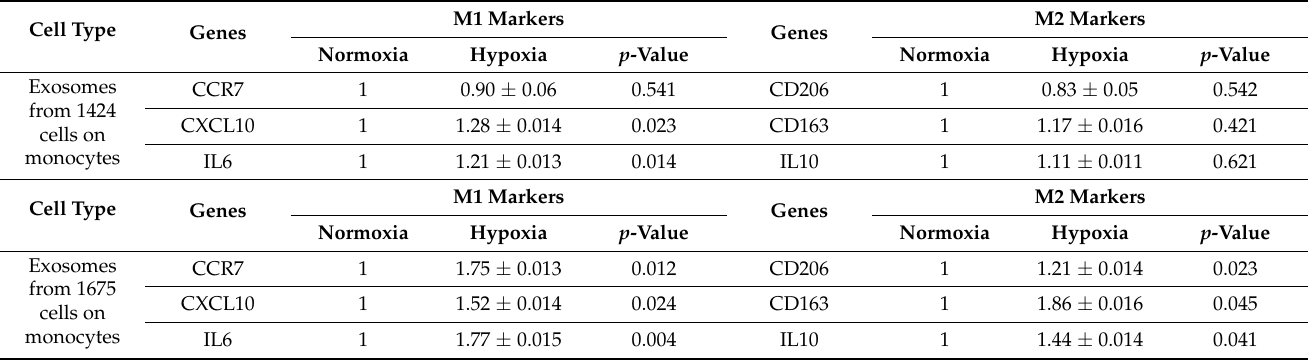
Table 3. Exosomes derived from melanoma 1424, and 1675 cells exposed to normoxia and hypoxia and applied into THP1 monocytes.